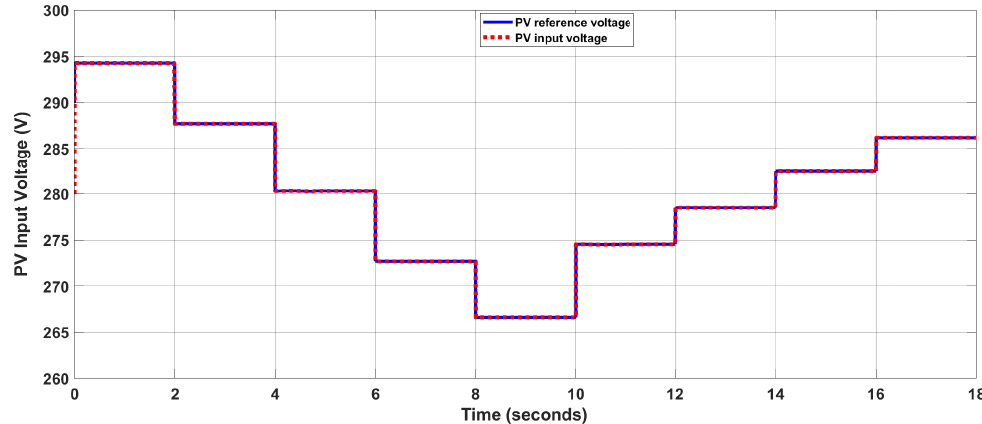
Figure 6. PV Current under maximum power point tracking ( x 2 ) .